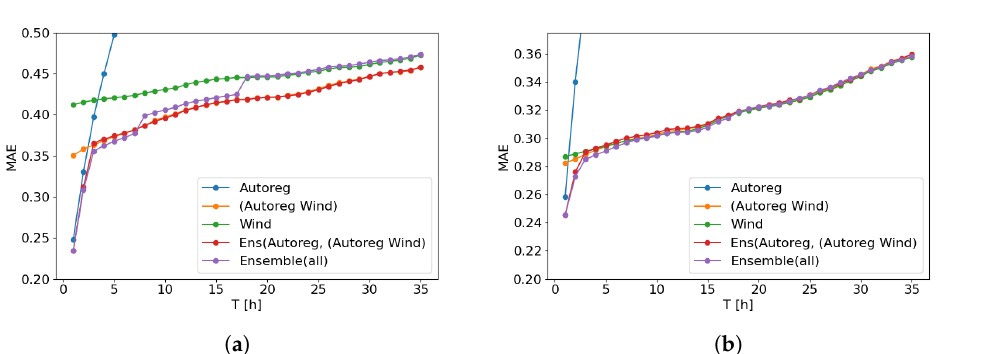
Figure 7. Model performance within the prediction range up to 36 h ahead. ( a ) Farm A. ( b ) Farm